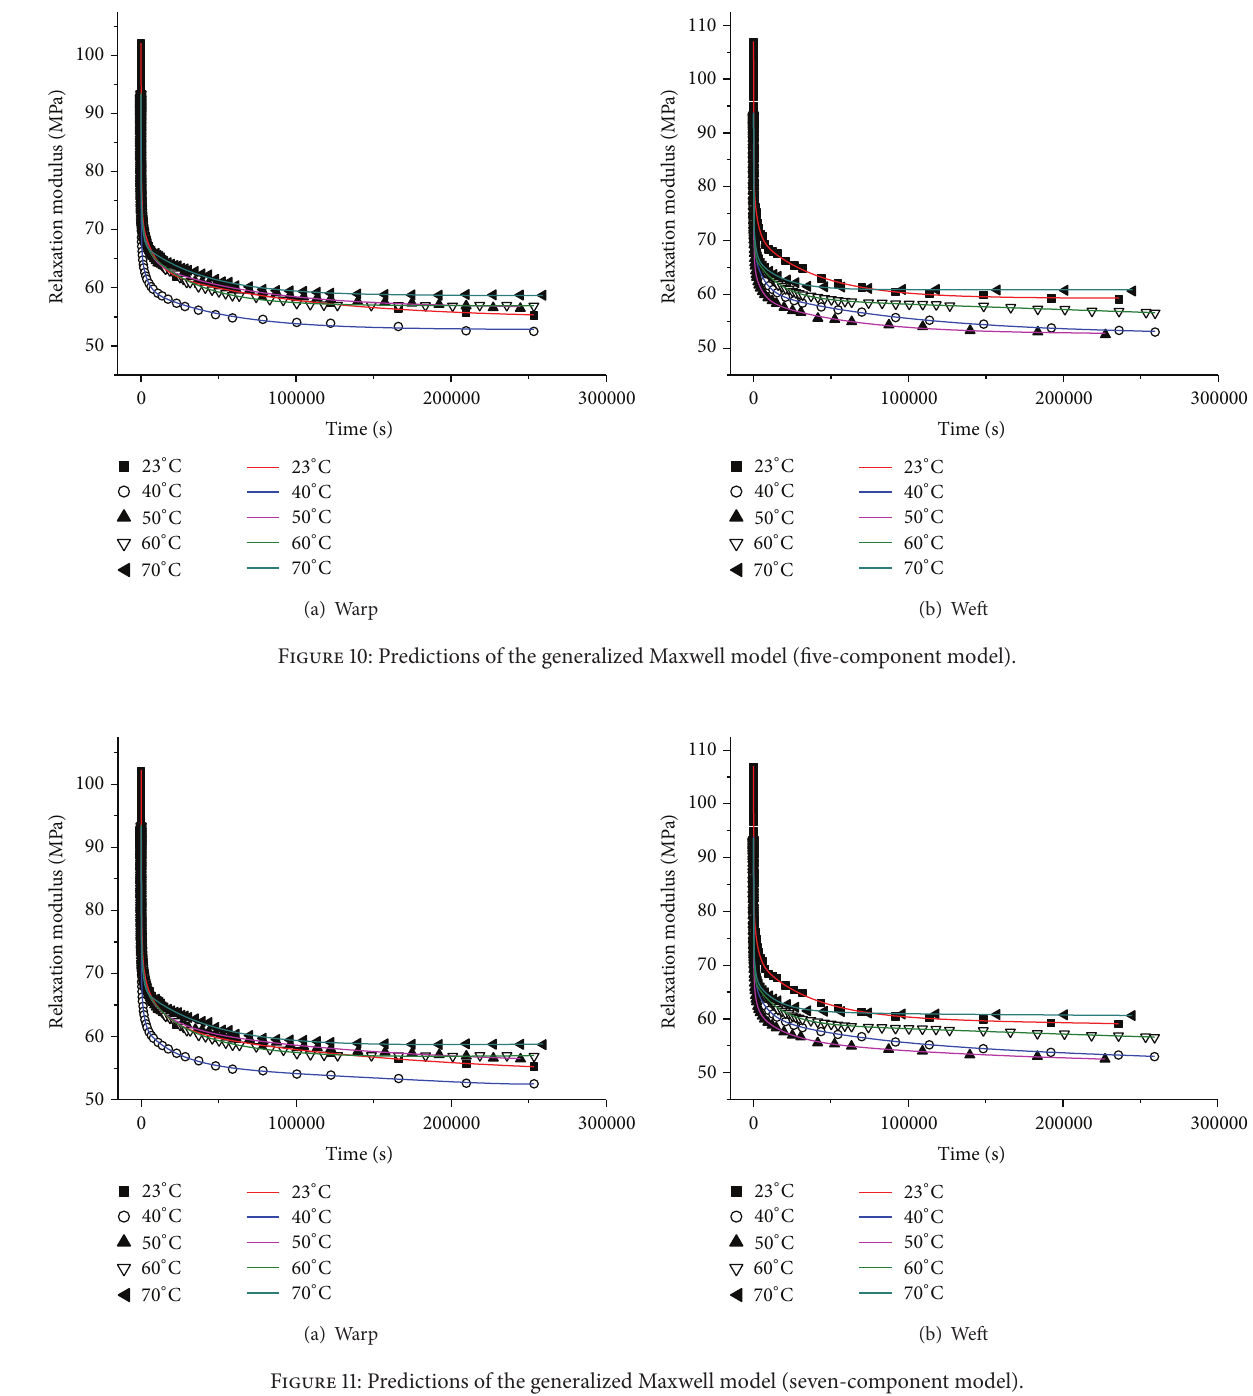
Figure 11: Predictions of the generalized Maxwell model (seven-component